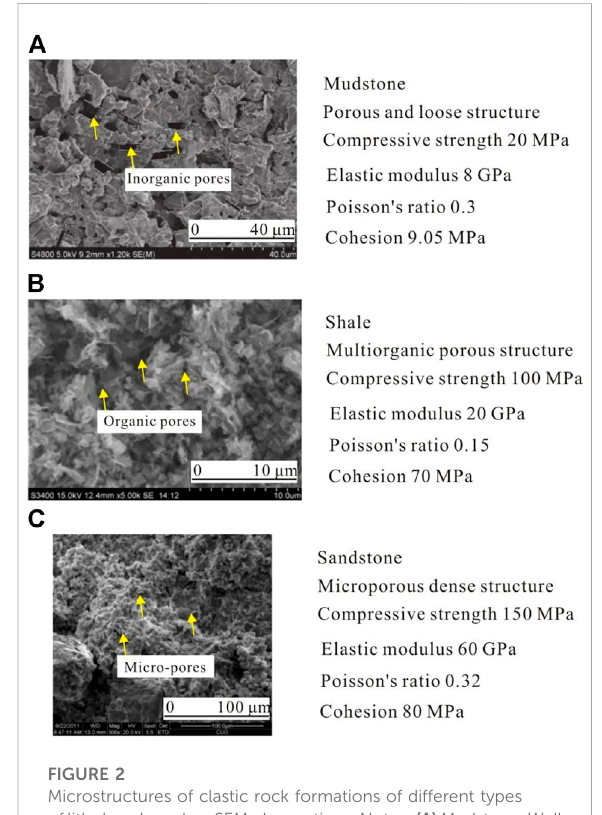
FIGURE 2 Microstructures of clastic rock formations of different types oflithology basedon SEM observations.Notes: (A) Mudstone, Well S1, 2243 m; (B) Shale, Well S1, 2247 m; (C) Sandstone, Well S1, 2255 m.